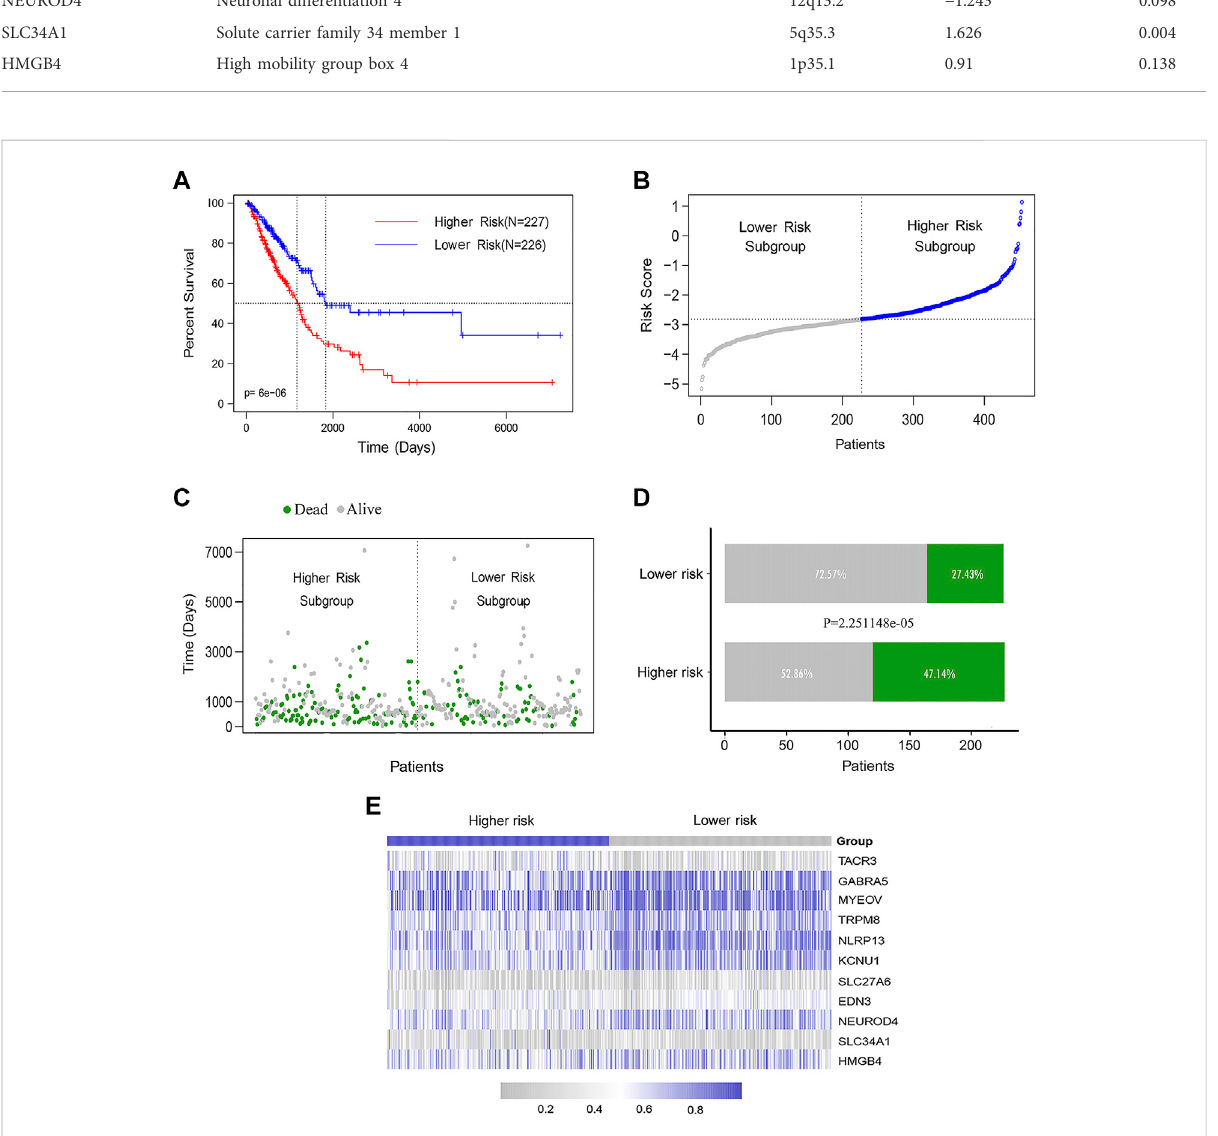
FIGURE 4 The DNA methylation feature for predicting OS prediction in LUAD patients. (A) K-M assessed OS based on the DNA methylation feature. The LUADpatientsweredividedintothelower-risk( n =226)andhigher-risk(n=227)subgroupsaccordingtothemedianofthemethylationscores.Log ranktestwasusedbetweencurves( p < 0.0001). (B) ThedistributionoffeaturescoresforDNAmethylationfeatureofpatients. (C – D) Thedistribution of survival status of LUAD patients in the lower- and higher-risk groups (Chi-square test, p < 0.0001). (E) The methylation β value spectrum of 11 DNA methylation feature